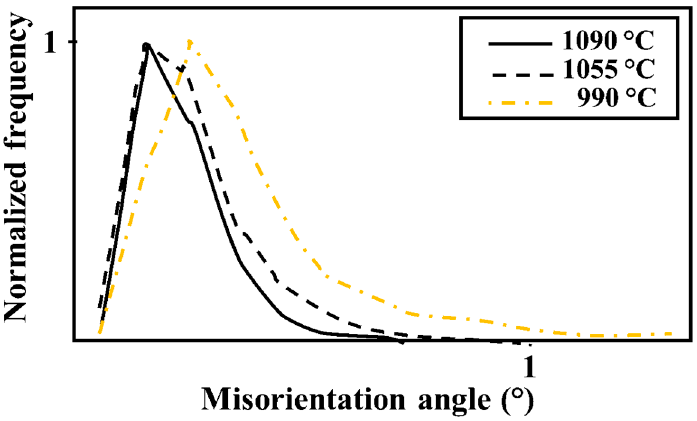
Figure 8. LMO angle distributions for γ at different aging temperatures.